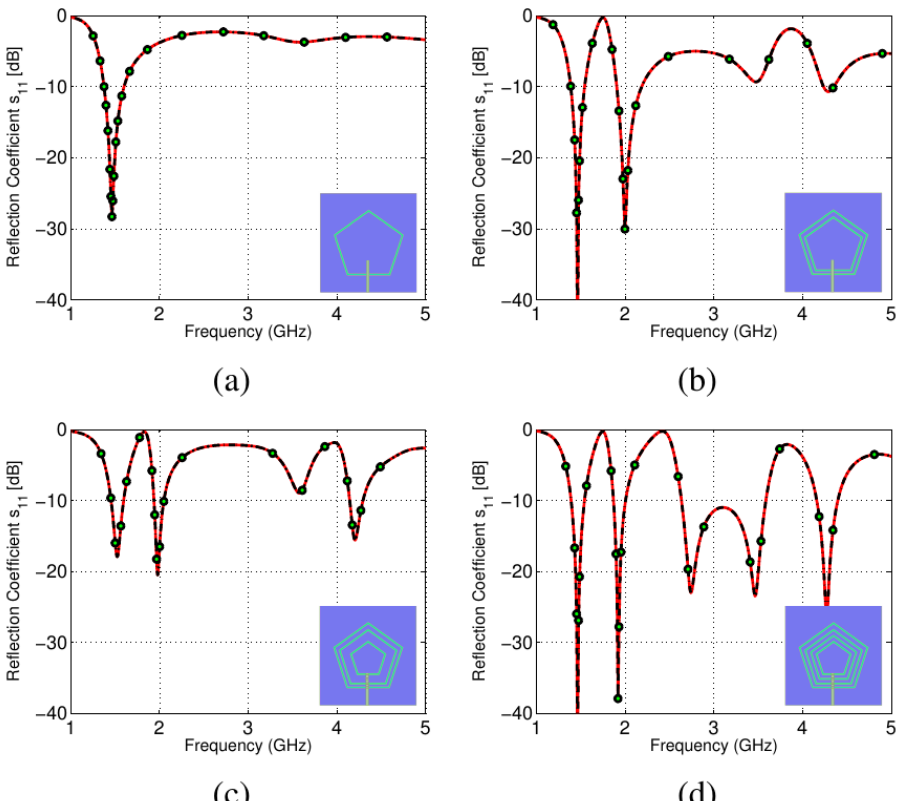
Figure 3. Steps in the design process: ( a ) S 11 with one slot, ( b ) S 11 with two slots, ( c ) S 11 with four slots, ( d ) S 11 with an inner pentagonal plate slot.